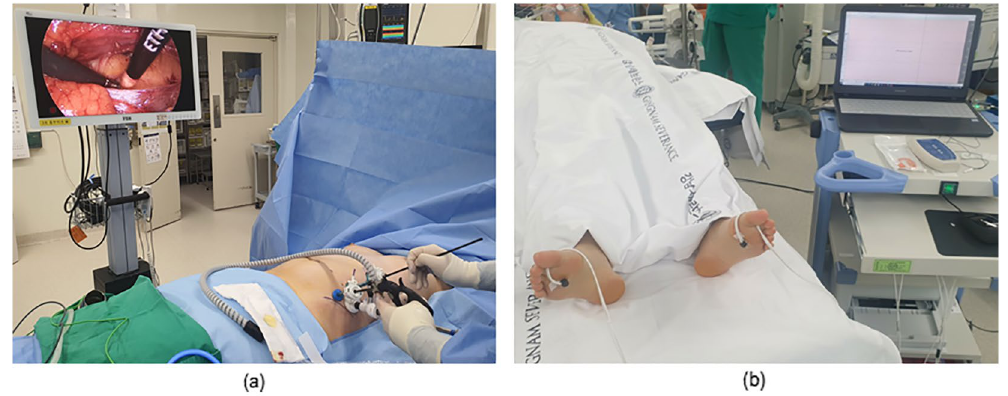
Figure 1. Performance of endoscopic lumbar sympathectomy. ( a ) The patient was lying down in supine position during the surgical procedure under general anesthesia. Three trocars were inserted on the lateral abdominal wall between the rib cage and hip bone. ( b ) A probe of laser doppler flowmetry was attached on the center of each sole of the patient by a holder using double-sided adhesive